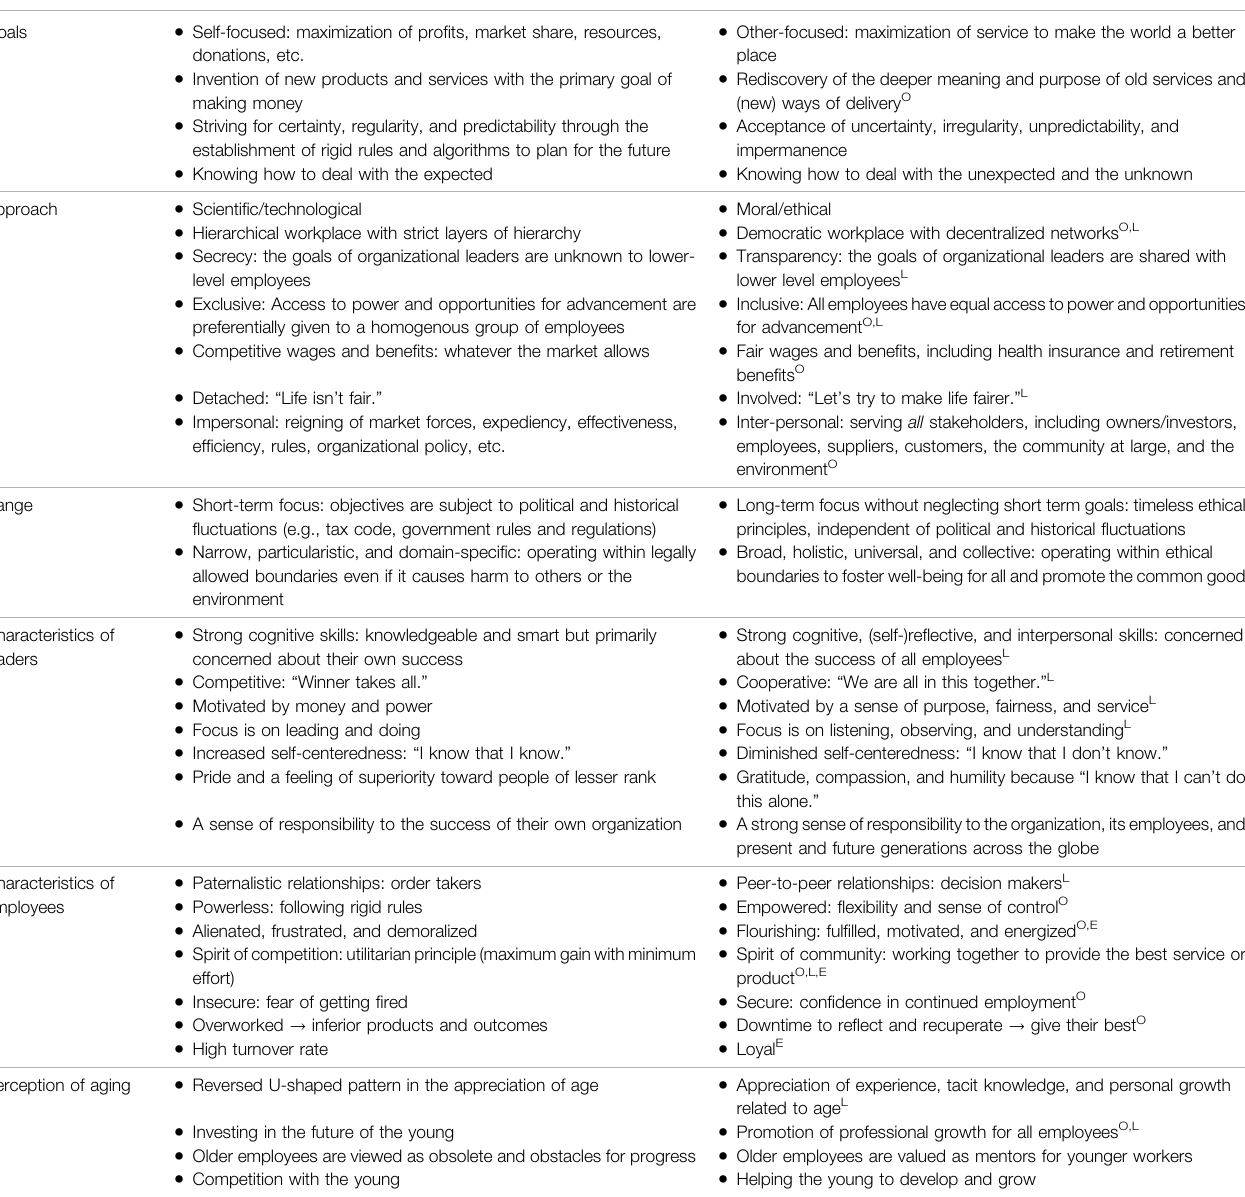
TABLE 1 | Differencesbetween not-so-wise and wise organizations. Area Not-so-wise organizations Wise organizations Goals